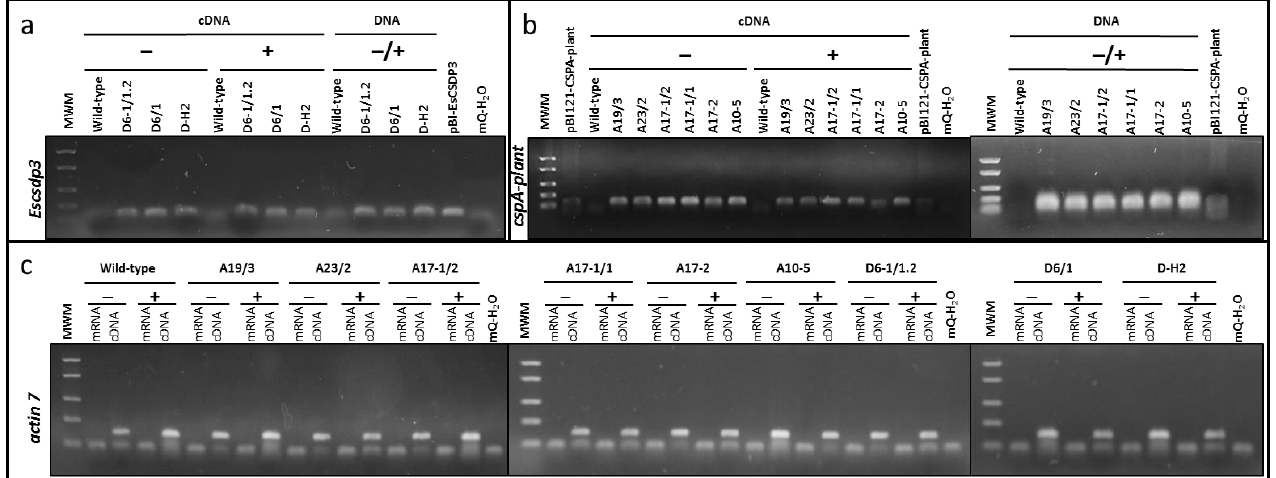
Figure 7. RT-PCR analysis of three genes ( Escsdp3 ( a ), cspA-plant ( b ) and housekeeping actin ( actin 7 ) genes ( c )) in rapeseed plants. MWM-molecular weight marker (FastRulerTM Low Range DNA ladder-1500, 850, 400, 200, 50 bp); shows non-hardened ( − ) and hardened (+) transgenic rape lines and wild type. The PCR products from Escsdp3 (amplification fragment of 154 bp) were separated in a 1.4% agarose gel at 100 mA ( a ), cspA-plant (amplification fragment of 157 bp) in a 1.4% agarose gel at 70 mA ( b ), and actin 7 (amplification fragment of 154 bp) in a 1.6% agarose gel at 70 mA ( c ).